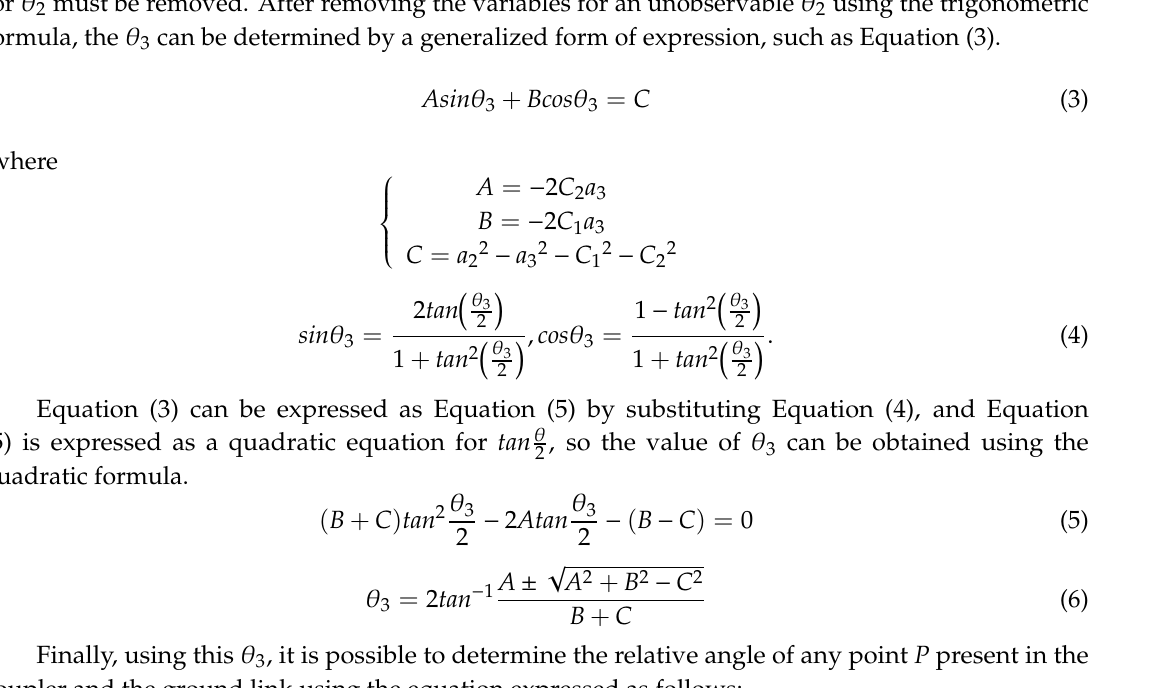
Figure 4. Decision of coupler point 𝑃 (cid:4593) and 𝑃 (cid:3045)(cid:3042)(cid:3031) to calculate actuator length.